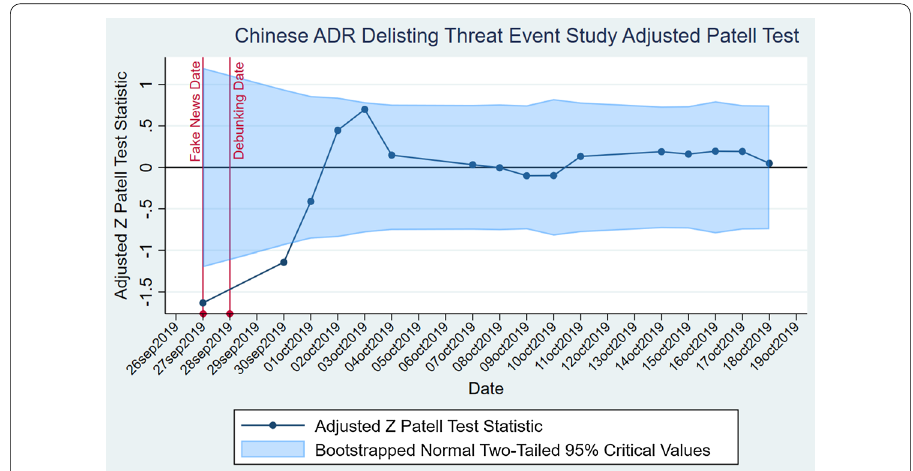
Fig. 4 Chinese ADR delisting threat event study adjusted Patell